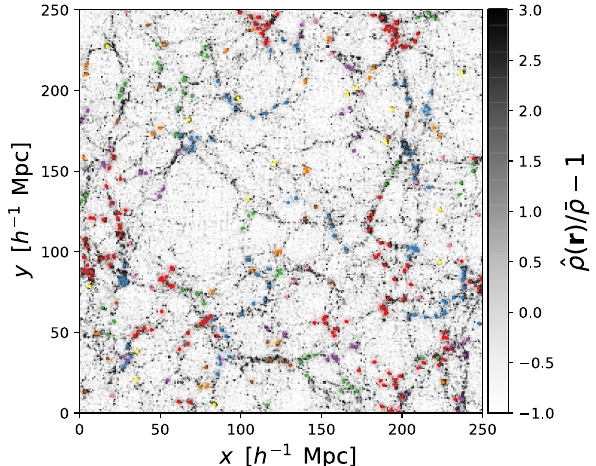
FIG. 2. Example of the cosmological simulations used in this work. This shows a ð 250 × 250 × 50 Þ h − 3 Mpc 3 slice of the dark matter distribution from a single QUIJOTE simulation, with the color bar indicating the fractional density of simulation particles in each pixel. The colored points show the positions of dark matter halos; these are used as a proxy for galaxies. To facilitate analysis of percolation and connectedness, galaxies are assigned to clusters (indicated by the various colors), via a burning (or “ friends-of-friends ” ) algorithm with a separation corresponding to reduced density η , here set to 0.2. Throughout this work, length is given in cosmologists ’ units of megaparsec divided by the reduced expansion rate h ≈ 0 . 7 ), in which the mean pairwise particle separation is ≈ 8 h − 1 Mpc.